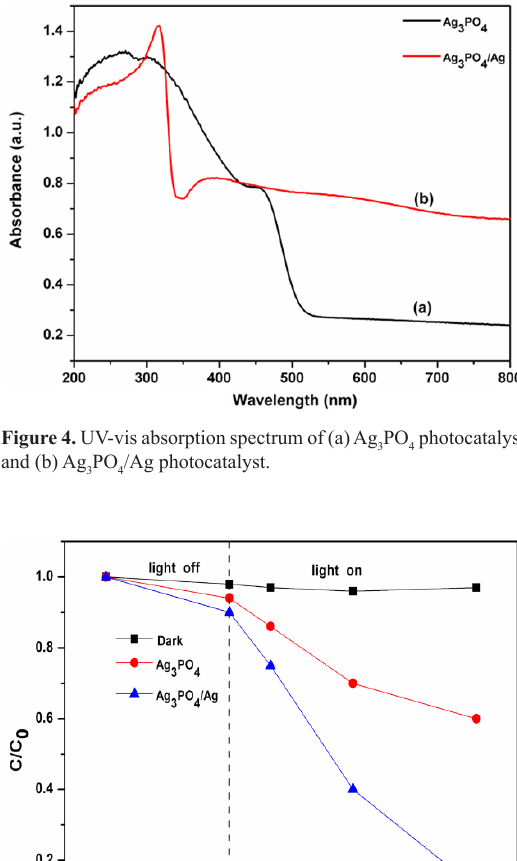
PO /Ag composites and 3 4